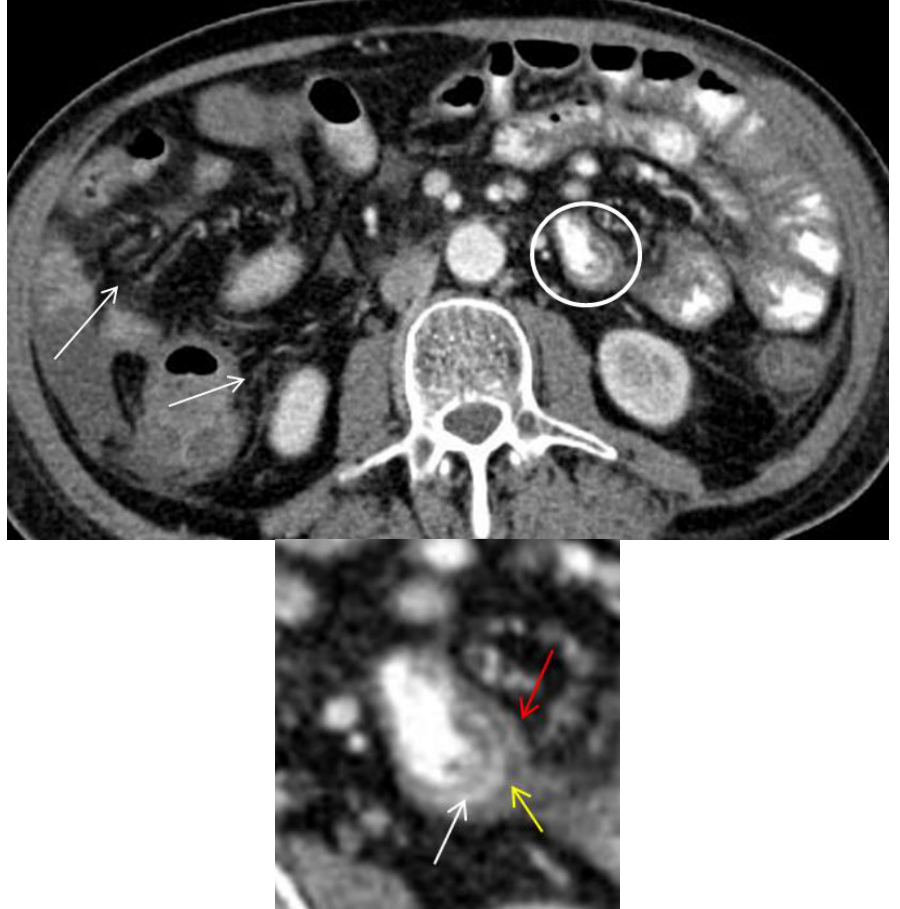
Figure 3. Axial CT image shows circumferential small bowel wall thickening (>3 mm) with trilaminar mural stratification in the small-bowel (circle and magnified image) with serosal enhancement (red arrow), low intramural attenuation (yellow arrow) and mucosal enhancement (white arrow) [2,13]. Low intramural attenuation can represent edema, inflammatory infiltrate or fat [13]. Stranding of the mesenteric fat is often observed in GIT-GVHD [2,6] (arrows). Mural stratification is a non-specific sign of bowel inflammation and has been shown to correlate with clinically active disease as opposed of a more homogenously enhancement due to fibrosis [14,15]. In this patient, three different patterns of mural stratification and mural enhancement were present in separate segments (Figures 2 and 3).